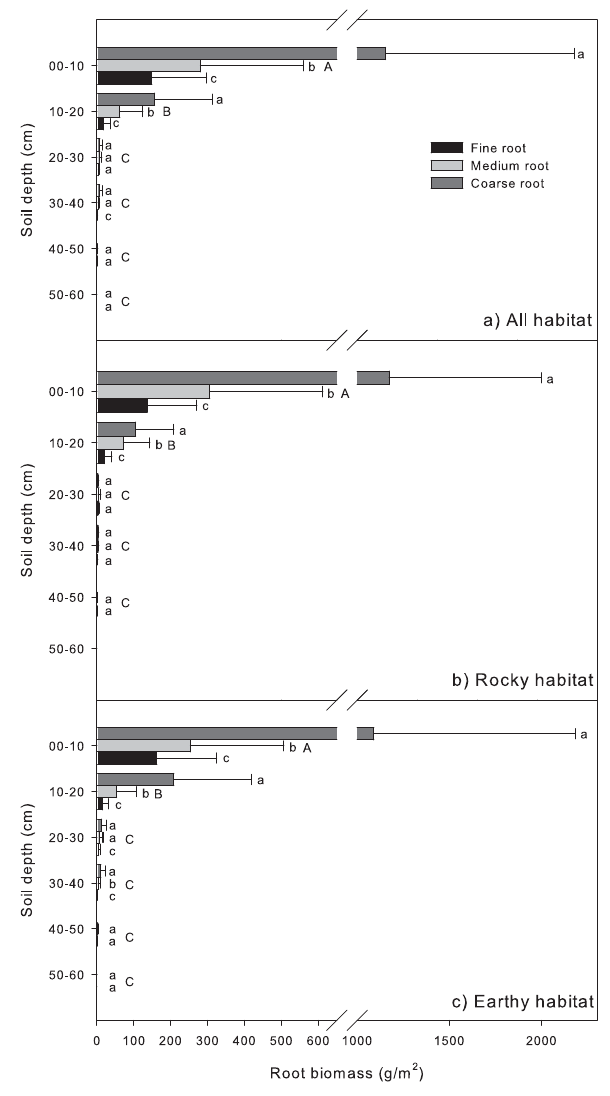
Figure 3. Root biomass in different habitats: (a) all habitats; (b) rocky habitat; (c) earthy habitat. The same letters above the error bars denote no significant differences and different letters denote significant differences. The lower cases are for various root diame- ter classes and the upper cases for various soil